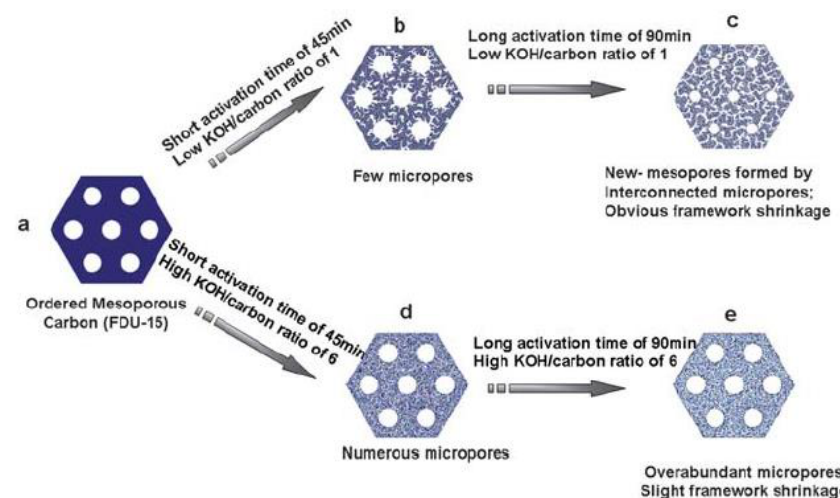
Figure 7. ( a – e ) Schematic illustration of the effects of KOH activation on the porosity development. Reproduced from [115], with permission from Royal Society of Chemistry, 2012.